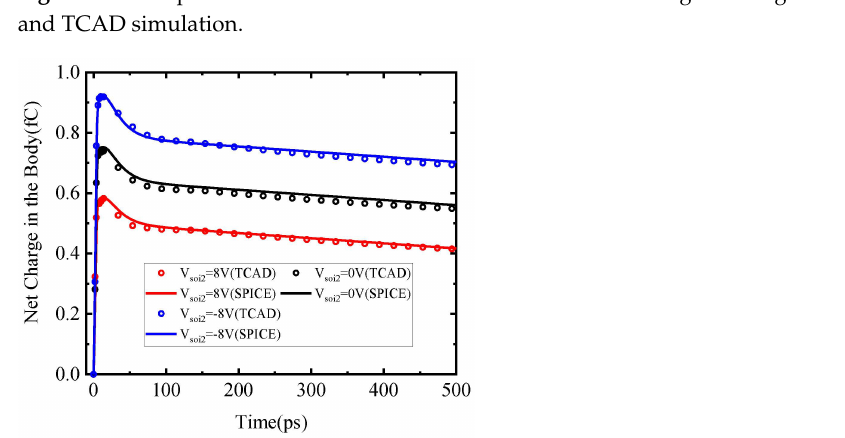
Figure 12. Total net charge with different back-gate voltages of the SPICE model and TCAD simulation.